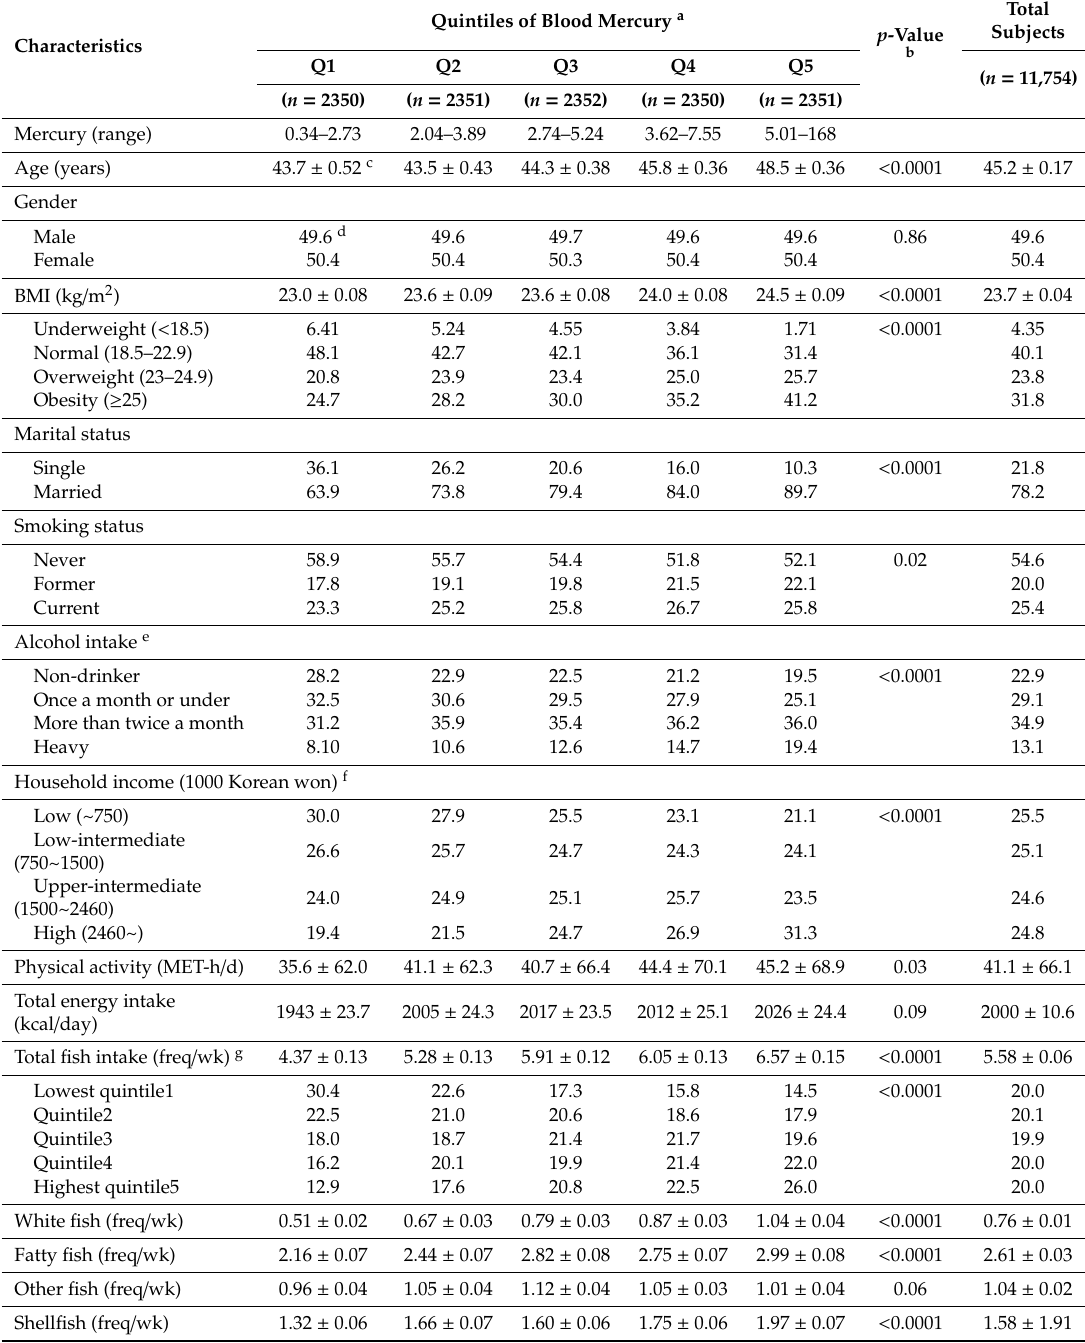
Table 1. Demographic and lifestyle characteristics of participants by quintiles of blood mercury, KNHANES